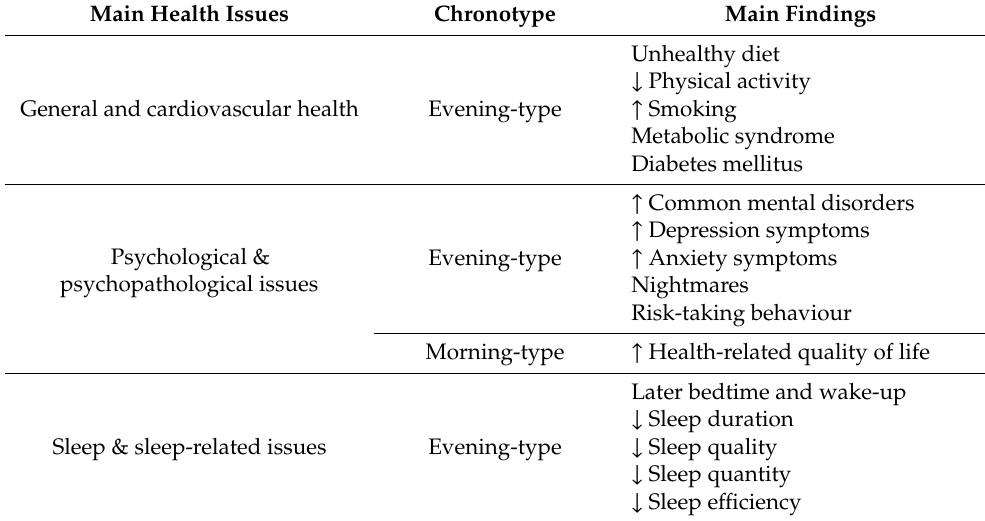
Table 1. Association between chronotype and main health issues [Fabbian 2016] (Symbols: ↑ Increased; ↓